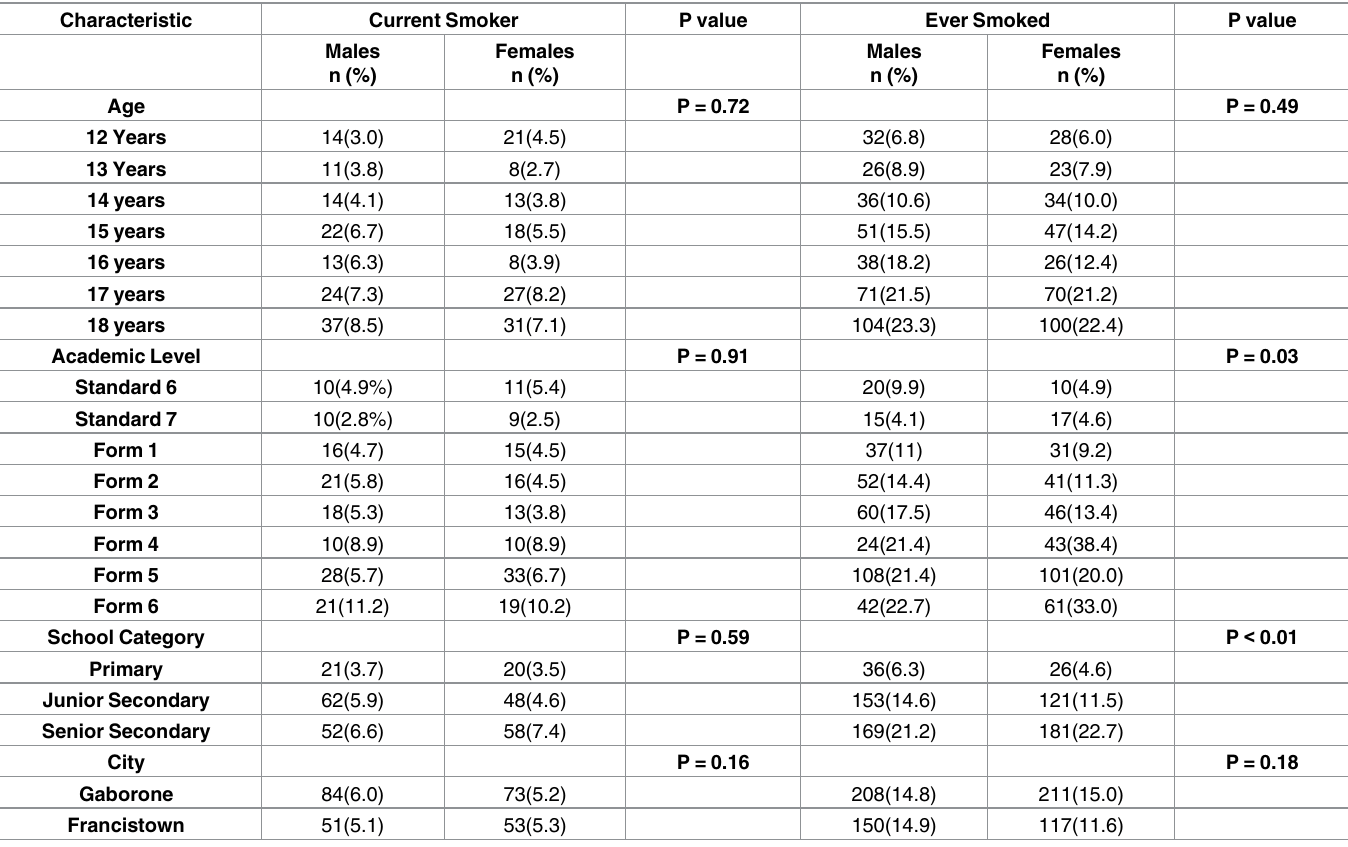
Table 2. Current smoker and ever-smoked associations with demographic